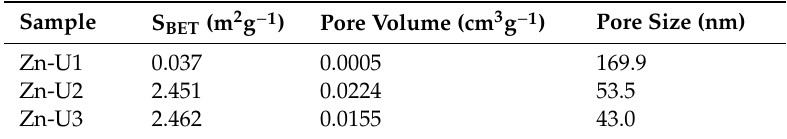
Table 1. The surface properties of the catalysts were examined by BET surface